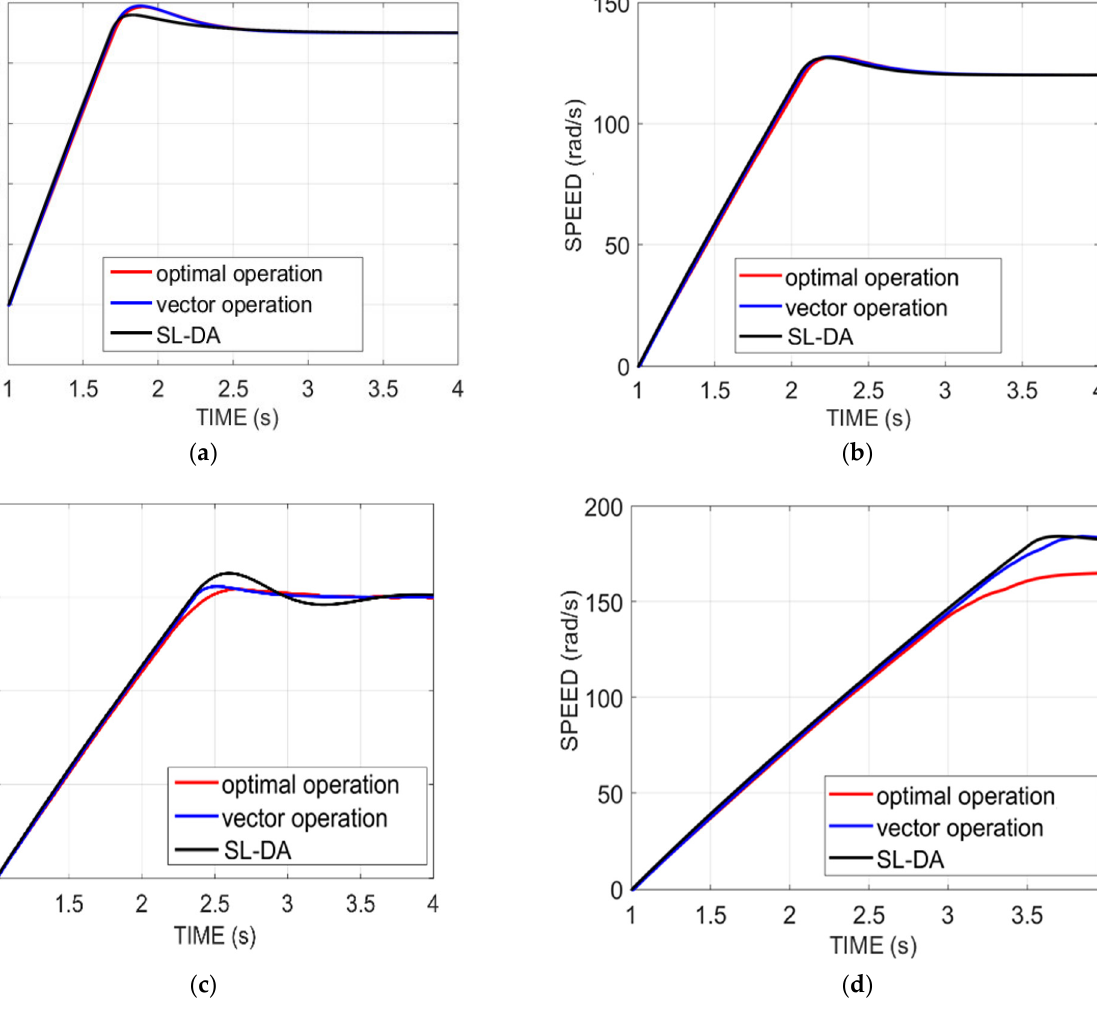
Figure 10. Speed analysis of proposed work over conventional models: ( a ) speed 90 and torque 130; ( b ) speed 120 and torque 150; ( c ) speed 150 and torque 180; and ( d ) speed 180 and torque 200.